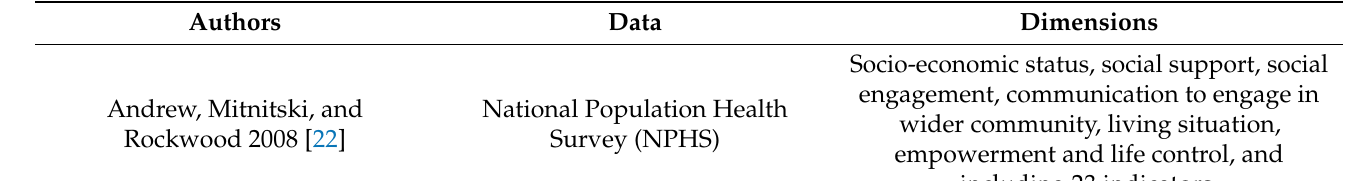
Table 1. Dimensions of vulnerability index